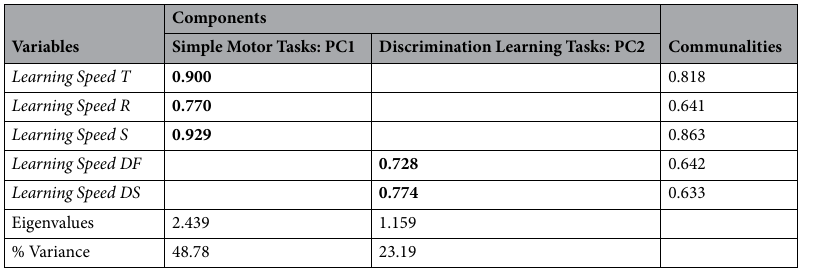
Table 1. Variable loadings in a principal component analysis (PCA). Varimax rotation with Kaiser normalization. Loadings > 0.7 are indicated in boldface. Communalities indicate a proportion of each variable’s variance that can be explained by the principal components. Eigenvalues indicate eigenvalues as obtained by the PCA. T = Target task, R = Room task, S = Scale task, DF = Discrimination Feature task, DS = Discrimination Size